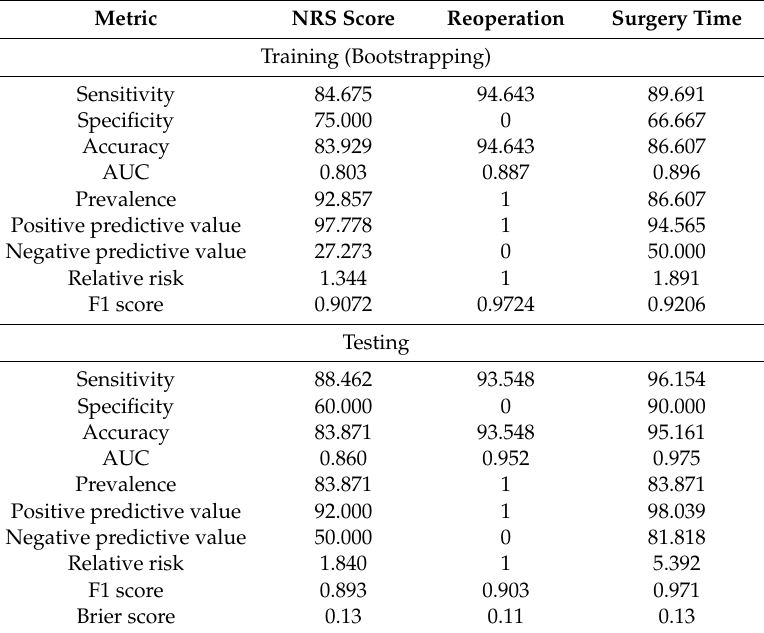
Table 3. Estimated results of the training and evaluation